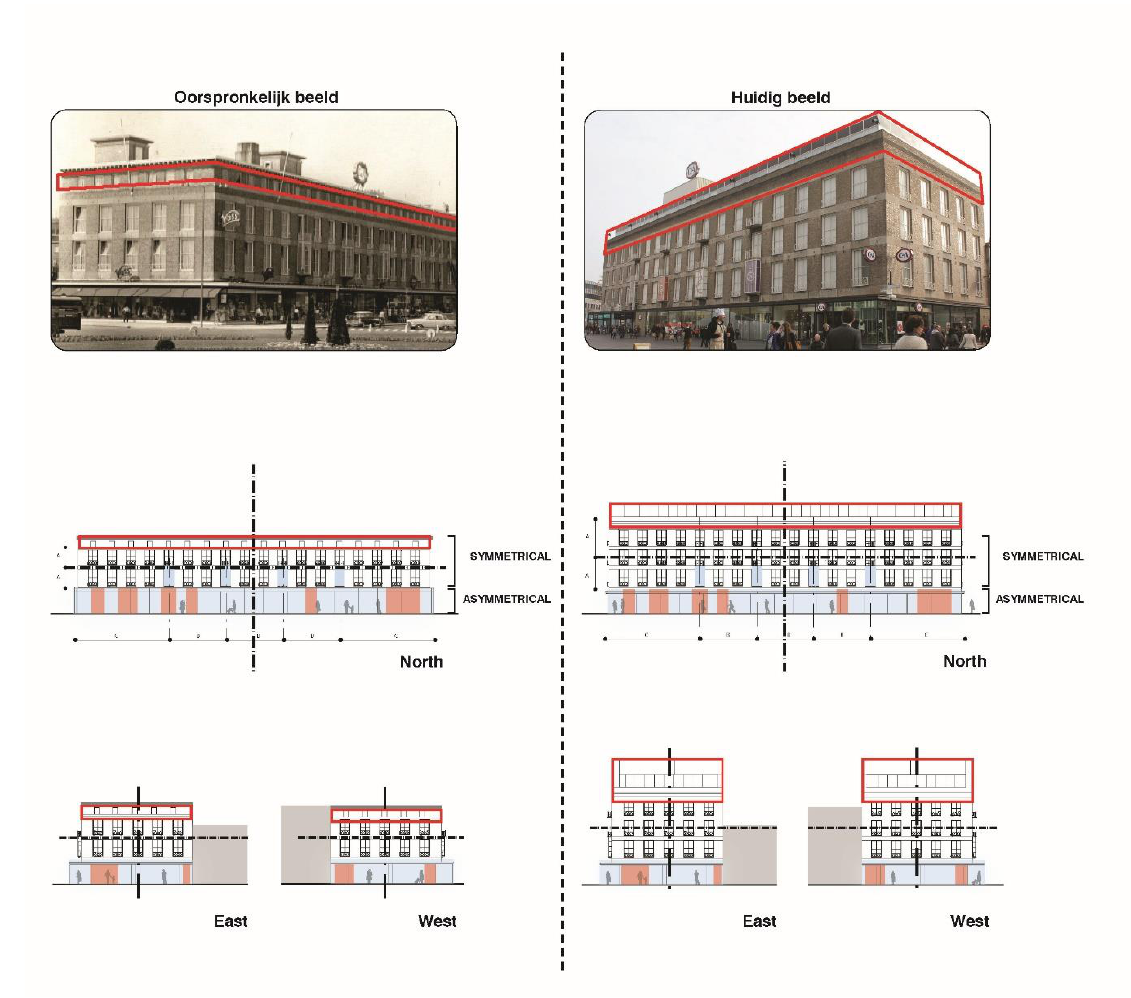
Fig. 1 18 Septemberplein,